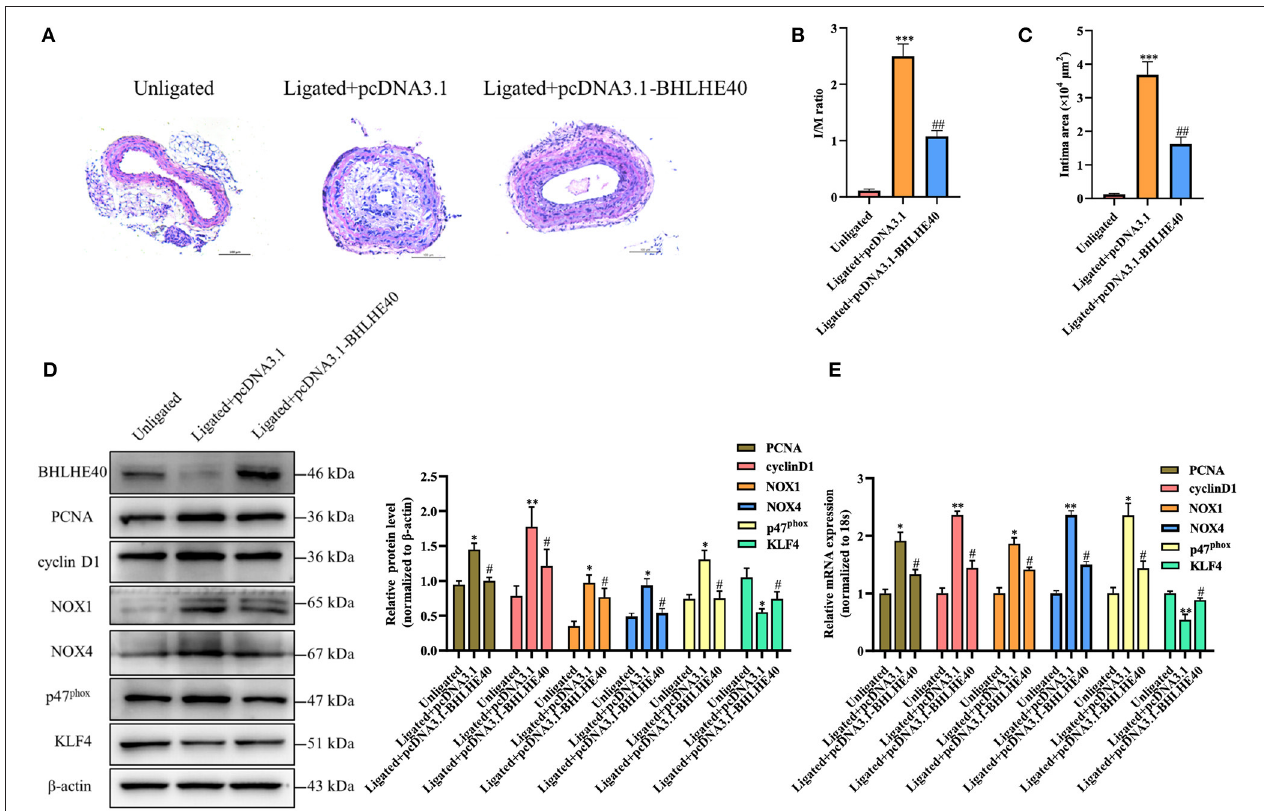
FIGURE 7 | BHLHE40 overexpression alleviates neointimal formation, proliferation and oxidative stress induced by carotid artery ligation. (A) Representative photomicrographs of the HE-stained sections of carotid arteries from unligated vessels, ligated + pcDNA3.1 vessels, and ligated + pcDNA3.1-BHLHE40 vessels ( n = 4). Scale bars = 100 µ m. (B,C) Morphometric quantification of I/M ratio and the intima area in the different groups. *** p < 0.001 vs. Unligated group, ## p < 0.01 vs. Ligated + pcDNA3.1 group. (D) BHLHE40, PCNA, cyclin D1, NOX1, NOX4, p47 phox and KLF4 expression in unligated, ligated + pcDNA3.1 and ligated + pcDNA3.1-BHLHE40 carotid arteries was detected by Western blotting. Statistic of band intensities is shown on the right ( n = 3). * p < 0.05 and ** p < 0.01 vs. Unligated group, # p < 0.05 vs. Ligated + pcDNA3.1 group. (E) PCNA, cyclin D1, NOX1, NOX4, p47 phox and KLF4 expression in unligated, ligated + pcDNA3.1